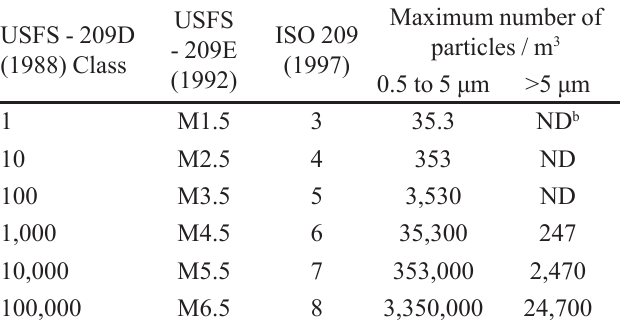
TABLE I - Classification based on number of particles allowed per cubic meter, according to three different systems (United States Federal Standard - USFS)